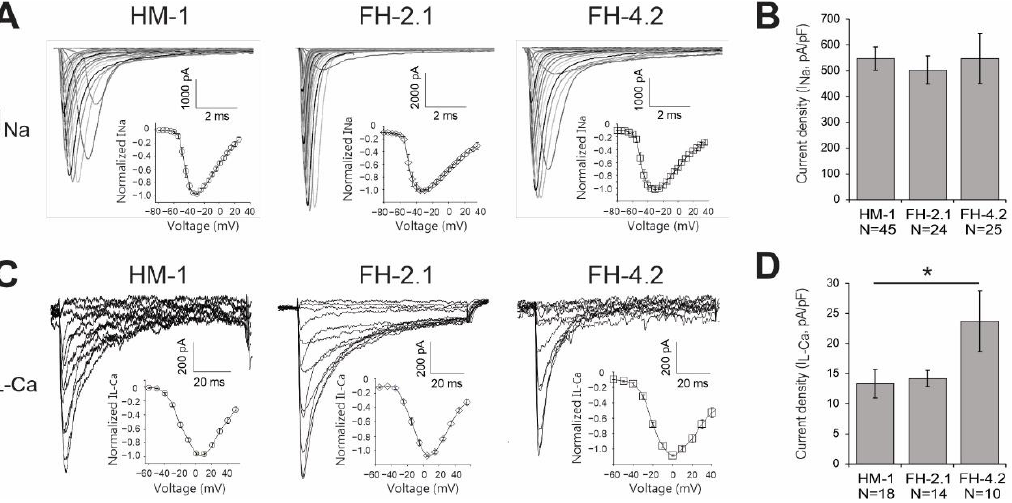
Figure 8. Functional expression of voltage-gated Na + and Ca 2+ ion channels in ESC- and FH-PSC- derived CMs. ( A ) Na + channel currents were elicited by a family of 100 ms depolarizations from a −90 mV holding potential (HP) to voltages ranging from −60 to −55 mV in 5 mV steps. ( C ) Ca 2+ channel currents were measured with a double-pulse protocol. First, a 100 ms depolarization from an HP of −90 mV to −40 mV was applied to inactivate Na + and T-type Ca 2+ channels, and then L-type Ca 2+ channels were elicited by a family of 67 ms depolarizations to voltages ranging from −60 to −50 mV in 10 mV steps. In Na + channel ( A ) and Ca 2+ channel ( C ) experiments, leak subtraction P/4 protocol was applied from HP of −90 mV. Insets in ( A ) and ( C ) show the current–voltage (I–V) relationships of I Na and I CaL , respectively. Peak Na + ( B ) and L-type Ca 2+ current densities ( D ) in HM-1 ESC-CMs, FH-2.1 CMs, and FH-4.2 CMs were determined at −40 mV and 0 mV, respectively. Data are presented as the mean ± SEM. N indicates the number of cells analyzed. Statistical analysis was performed by one-way ANOVA followed by the post hoc Bonferroni’s test. p -values are only given for group comparisons for which the differences were statistically significant. * p < 0.05.